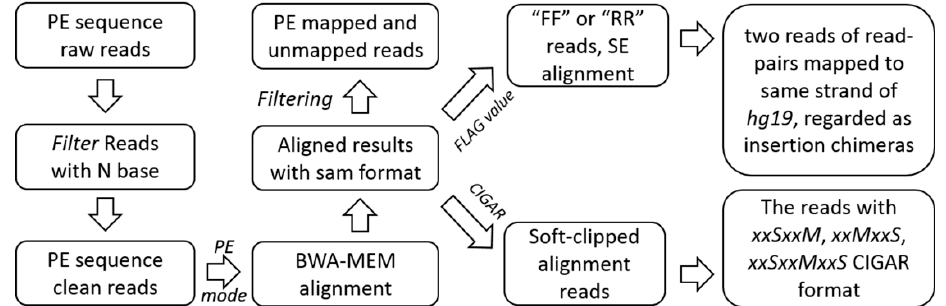
Figure 3. Pre-processing, alignment and filtrating. FF (forward / forward) is a pair of reads aligned in forward/forward order and RR (reverse/reverse) is a pair of reads aligned in reverse/reverse order. They were grouped into ‘not a proper pair’.